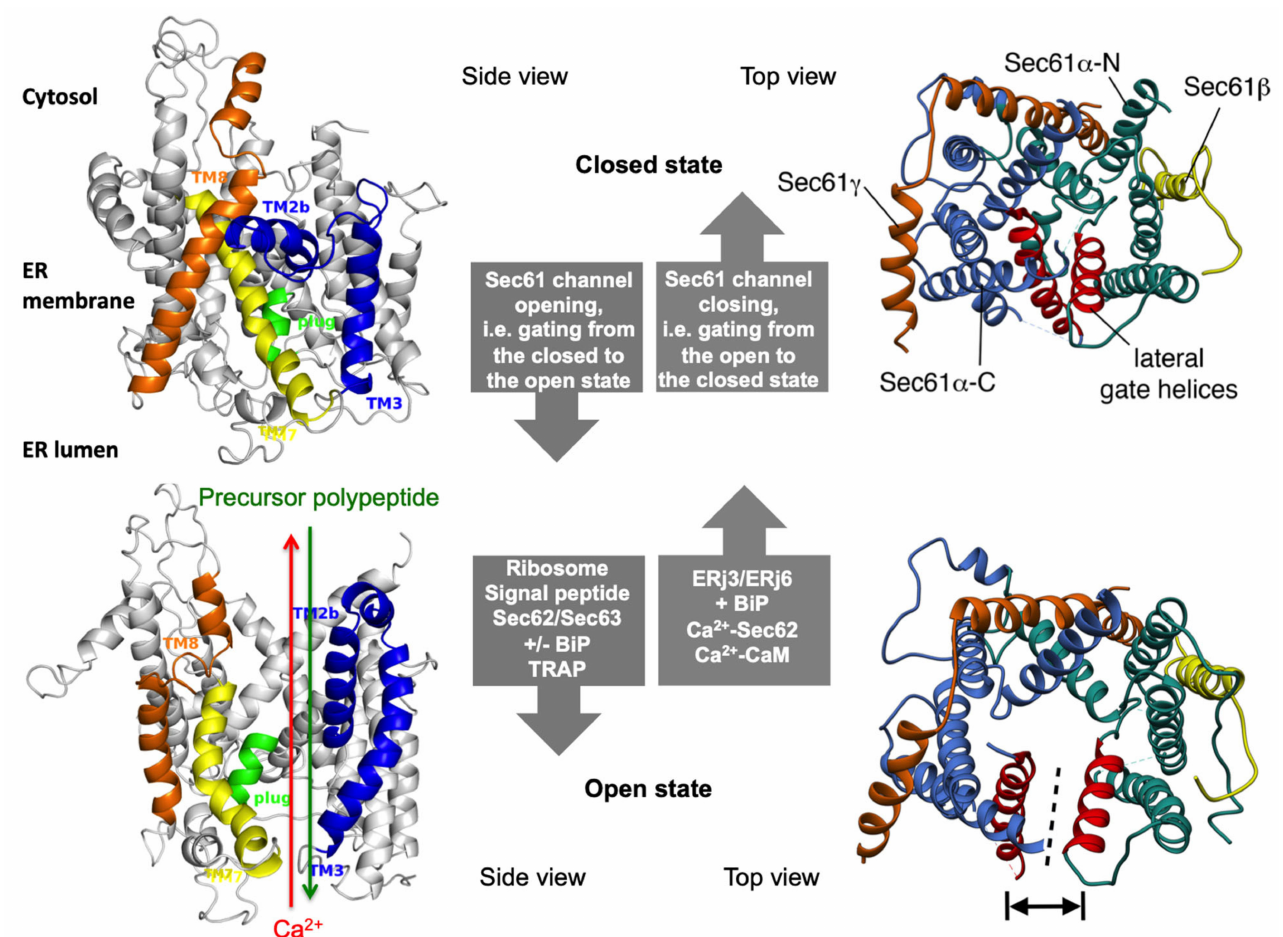
Figure 2. The concept of gating of the heterotrimeric Sec61 complex by signal peptides and allosteric effectors. The Sec61 channel is shown in its modeled closed (top) and open (bottom) conformational states, as viewed from the plane of the membrane (left) and in atomic models (PDB 3j7q, PDB 3jc2) as seen from the cytosol (right), respectively [57,58]. These two states are proposed to be in a dynamic equilibrium with each other. The fully open state of the Sec61 channel allows the initial entry of precursor polypeptides from the cytosol into the ER lumen and ER membrane, respectively, and is experimentally observed as cleavage of signal peptides by signal peptidase on the luminal side of the ER membrane. In addition, it allows the passive efflux of Ca 2+ from the ER lumen into the cytosol and is visible in live cell Ca 2+ imaging in cytosol and ER lumen. Ca 2+ efflux may also be possible in the expected transition state (not shown), which may be identical to the so-called primed state that can be induced by ribosomes in co-translational- and by the Sec62/Sec63 complex in post-translational-transport. The conformational changes of the modelled Sec61 complex were previously morphed and the role of BiP plus an ERj co-chaperone, such as Sec63 and ERj1, respectively, visualized for co-translational transport at (see Data Availability). The Ca 2+ -permeability of the open Sec61 channel as observed by live cell Ca 2+ imaging can be seen in the video file (see Data